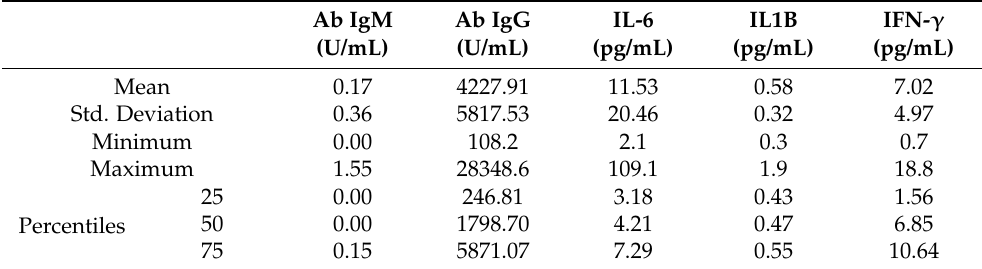
Table 4. Umbilical cord blood samples. Cytokines concentration.